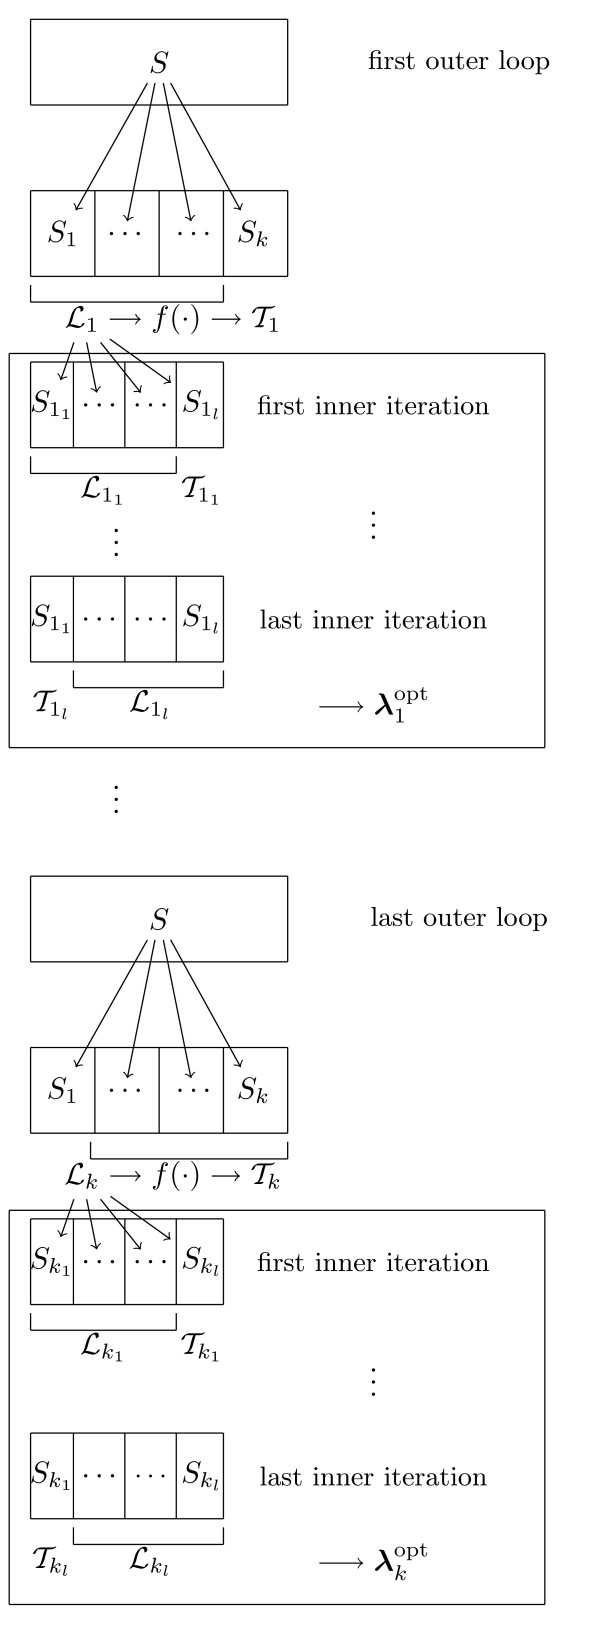
Hyperparameter tuning. Schematic display of nested cross-validation. In the procedure displayed above, k-fold cross-validation is used for evaluation purposes, whereas tuning is performed within each iteration using inner (l-fold) cross-validation.